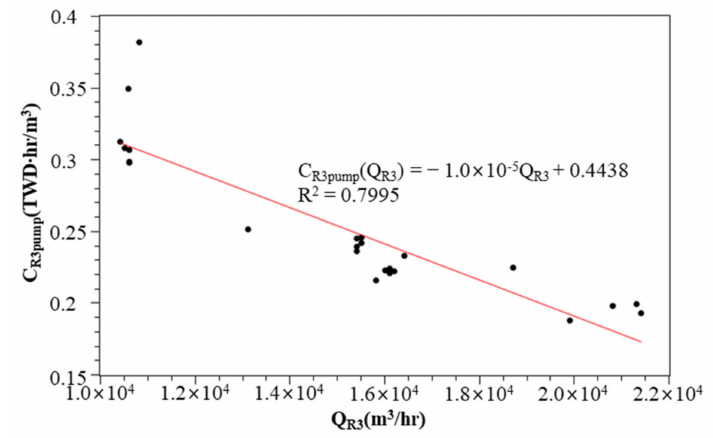
Figure 10. WTP R3 unit water discharge pumping cost function.